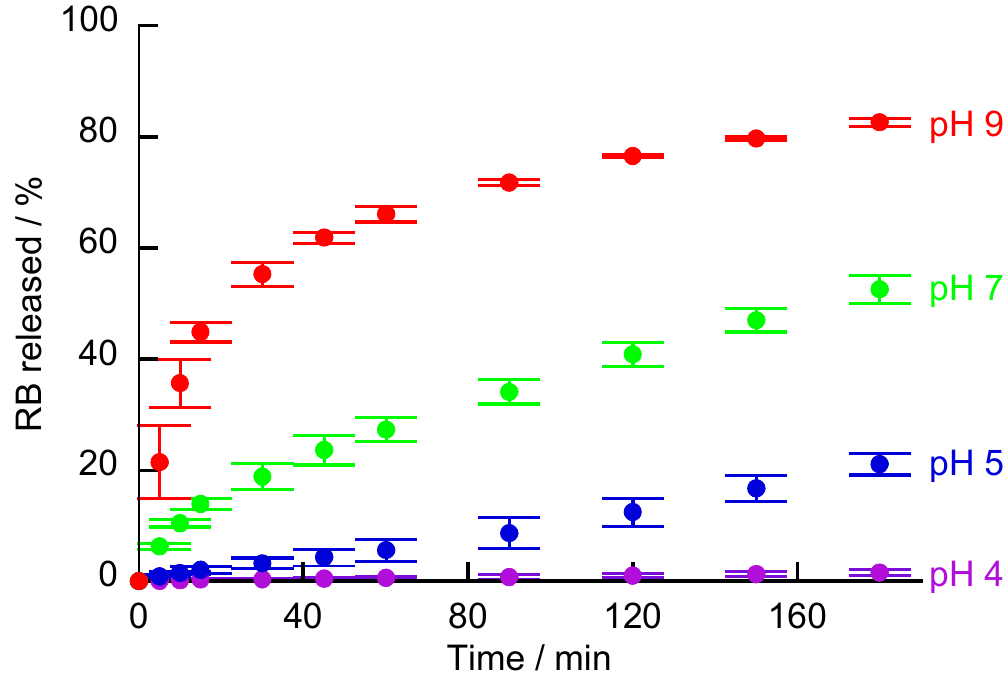
ff ers with various 5 films immersed in bu